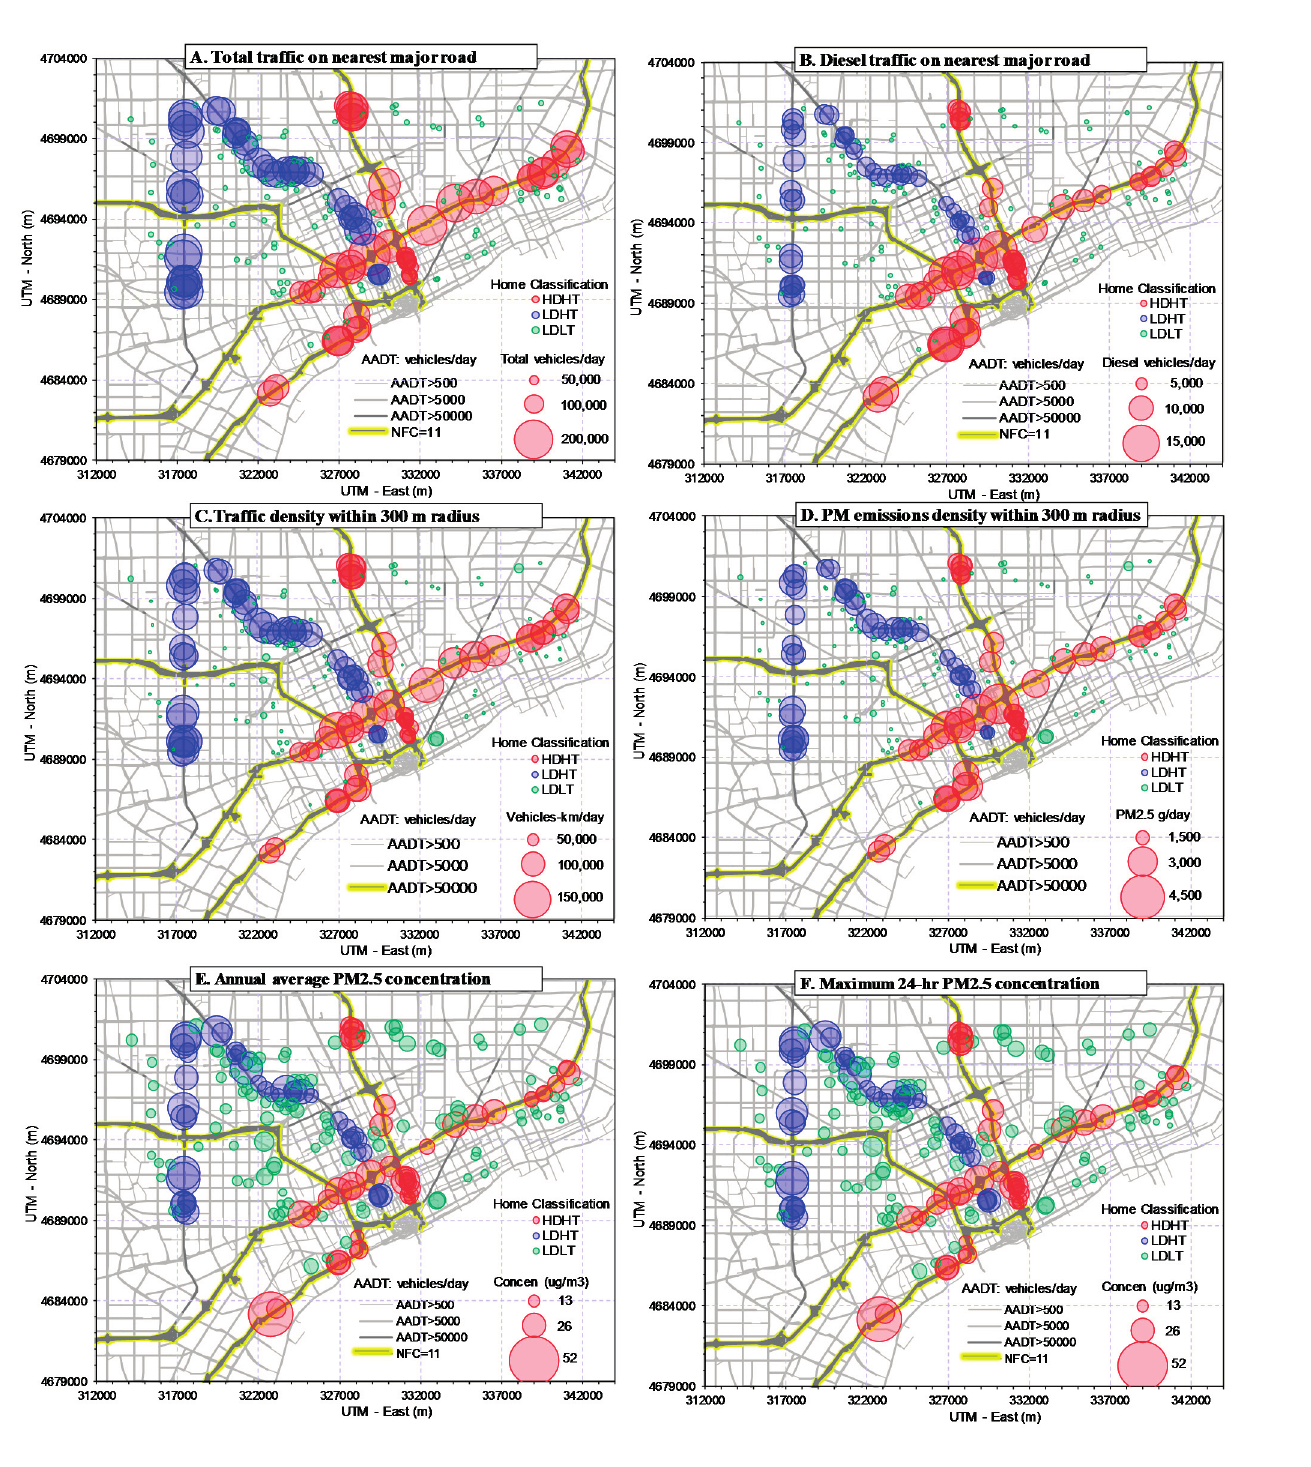
Figure 4. Depiction of selected exposure metrics mapped by home group (HDHT = high diesel/high traffic; LDHT = low diesel/high traffic; LDLT = low diesel/low traffic). ( A ) Total traffic volume on major roads nearest home; ( B ) Diesel traffic volume on major roads nearest home; ( C ) Traffic density for roads within 300 m of home. ( D ) PM 2.5 emissions density for roads within 300 m of home; ( E ) Annual average PM 2.5 concentrations due to on-road emissions; ( F ) Maximum 24-h average PM 2.5 concentrations due to on-road emissions. In ( A ) and ( B ), LDLT homes are shown as green circles without coding for traffic